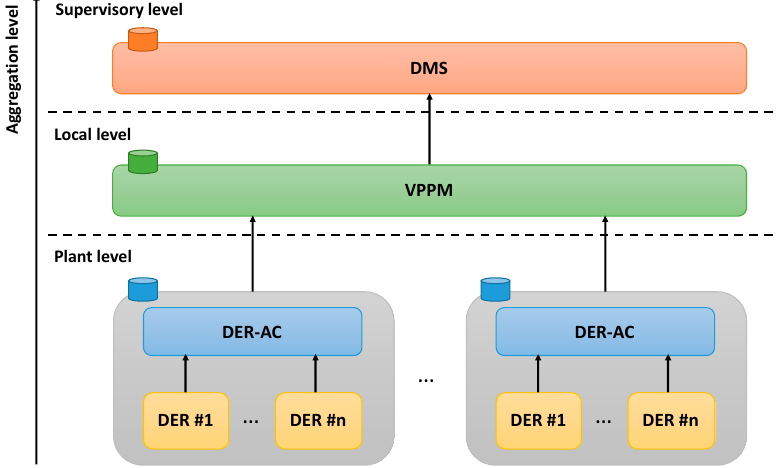
Figure 6. Architecture of the Information and Communication Technology (ICT) infrastructure supporting the proposed VPP approach. VPPM: Virtual Power Plant Monitor.